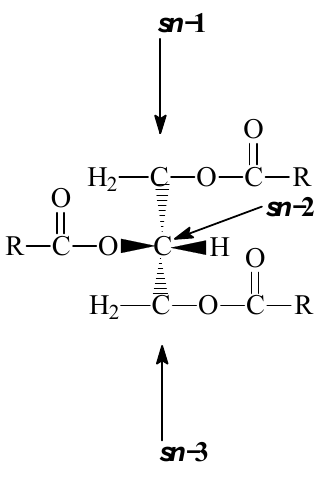
Figure 1. Triacylglycetol structure, R = fatty acid acyl